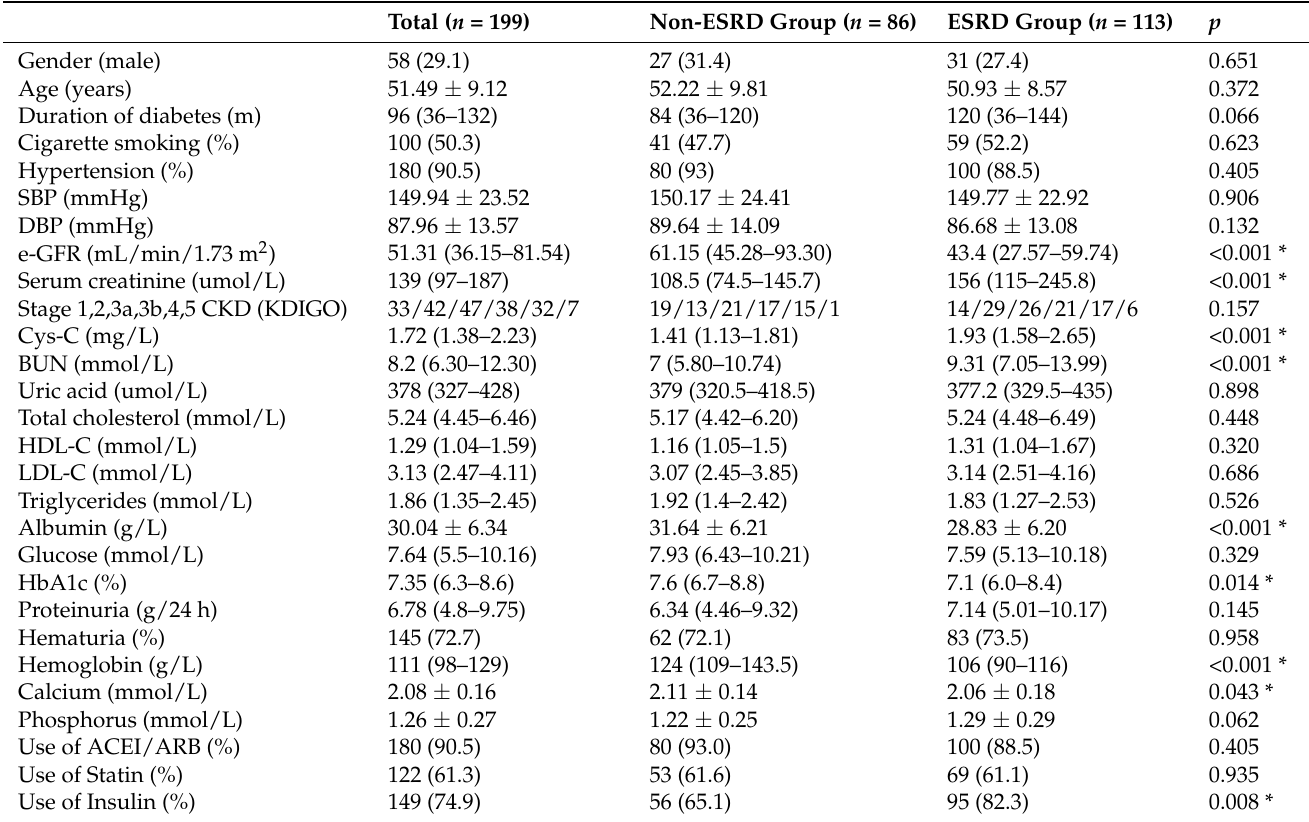
Table 1. Baseline clinical findings in ESRD and non-ESRD